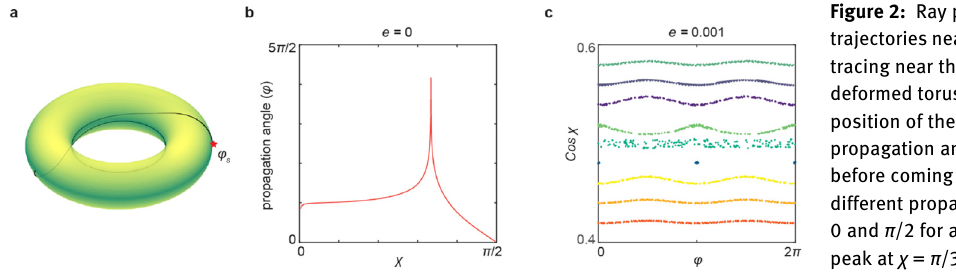
inner equator of an undeformed torus as shown in Figure 2b, where the propagated φ angles traversed by the rays (proportional to the propagation lifetime) before going back to outer equator are plotted as the y-axis. The ray trajectory near the inner equator is similar to the photon sphere in the case of black hole imitation with meta-